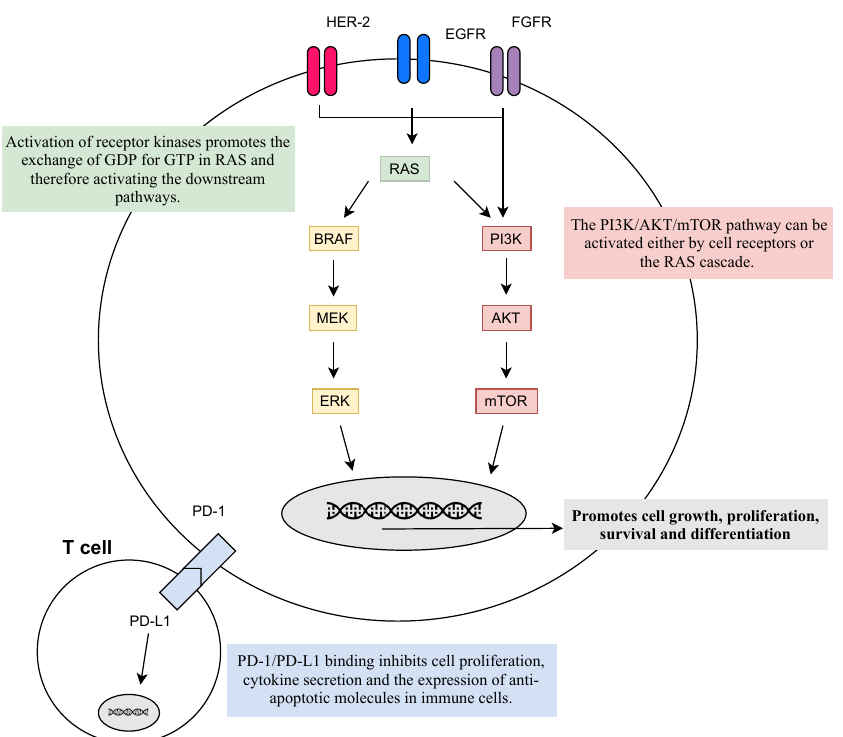
Figure 2. Physiological response to the activation of membrane receptors and immune receptors. Activation of receptor kinases, such as EGFR , FGFR , or HER-2 , promotes the activation of RAS and its downstream pathways that facilitate cell growth, proliferation, cell survival, and differentiation. However, mutations in the RAS family lead to its constitutive activation and the hyperactivation of the downstream pathways—leading to uncontrolled cell survival. On the other hand, PD-L1 is present on the cell surface of immune cells and its binding to tumor cells PD-1 inhibits cell proliferation, cytokine secretion, and the expression of anti-apoptotic molecules in immune cells culminating in the escape of cancer from immunosurveillance. The goal of target therapies is to diminish the activation of abnormal signalling pathways, which can be inhibited at every